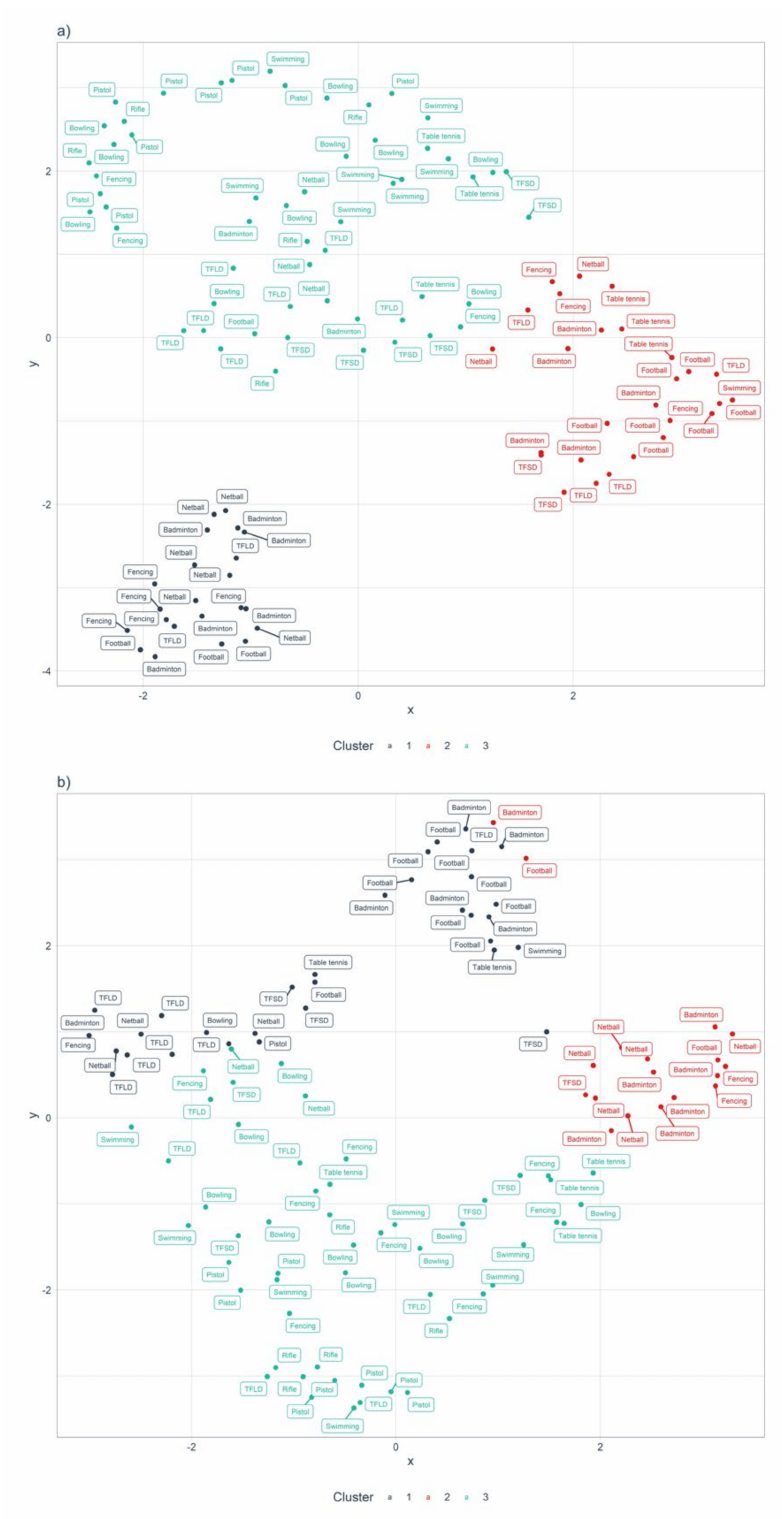
Figure 2. Uniform Manifold Approximation and Projection (UMAP) 2-dimensional projection with k-means cluster assignment. ( a ) Athlete hydration characteristics during low-intensity training. ( b ) Athlete hydration characteristics during high-intensity training. Cluster 1-Heavy sweaters with sufficient compensatory hydration habits (HSSH); Cluster 2-Heavy sweaters with insufficient compensatory hydration habits (HSIH); Cluster 3-Light sweaters with sufficient compensatory hydration habits